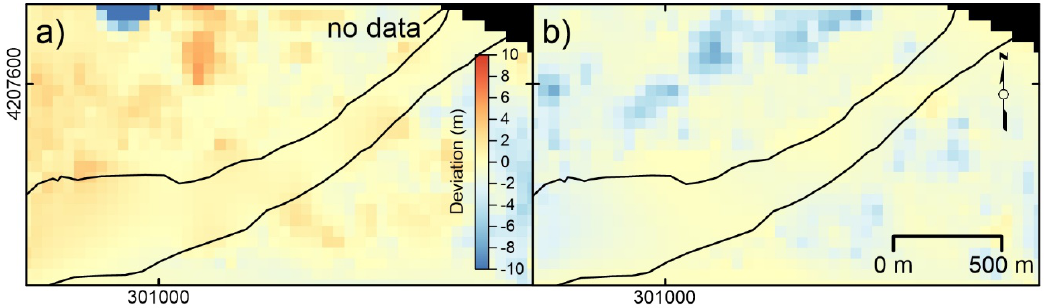
Figure 6. Slumgullion landslide and surrounding slopes. ( a ) Distribution of deviation in displacement along the X -axis. ( b ) Distribution of deviation in displacement along the Y -axis. UTM coordinates are shown at figure edges. Black lines indicate moving area boundary.